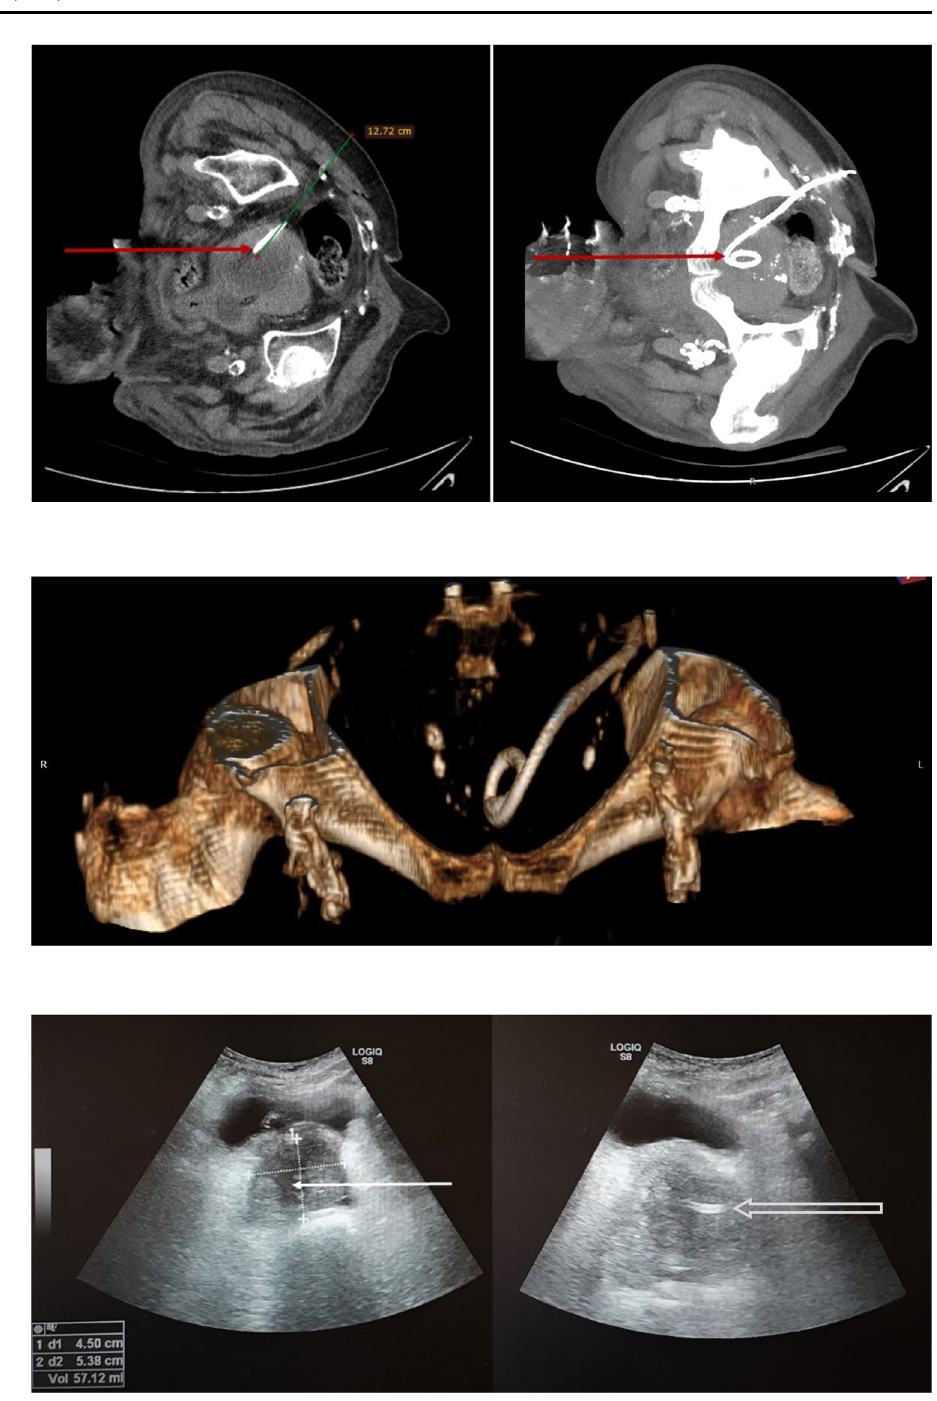
Fig. 5 Catheter (arrows) within the prostatic abscess seen under CT scan (oblique reformat with maximum intensity projection)